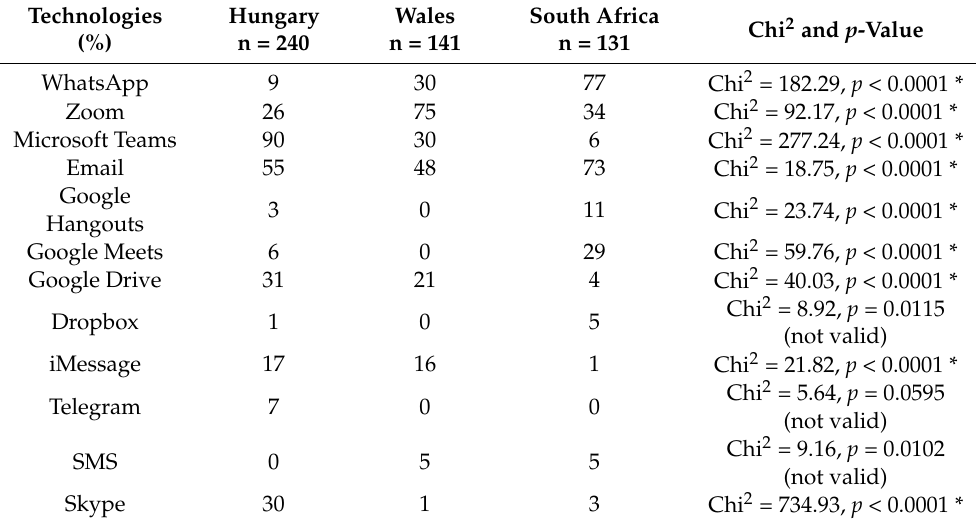
Table 2. Digital technologies most used by